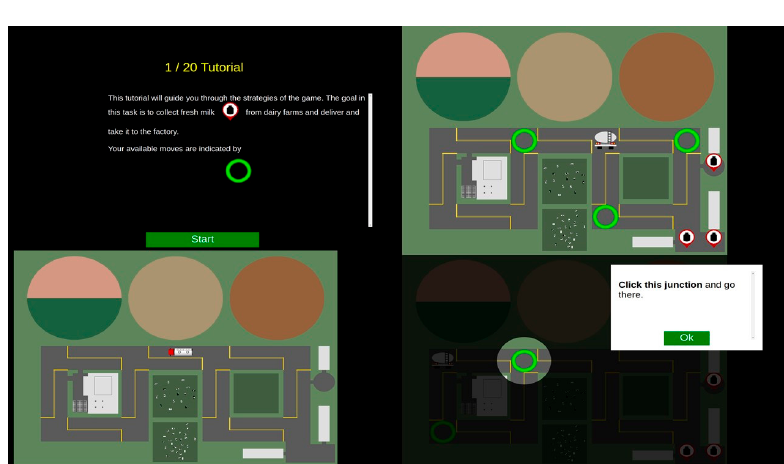
Table A2. Week 1 standardized Z scores for School Bus and Ambulance problem scenarios.